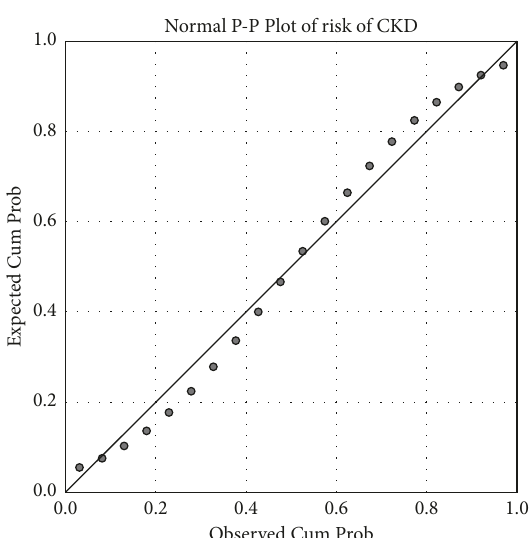
Figure 4: P–P plot of the risk of CKD occurrence.